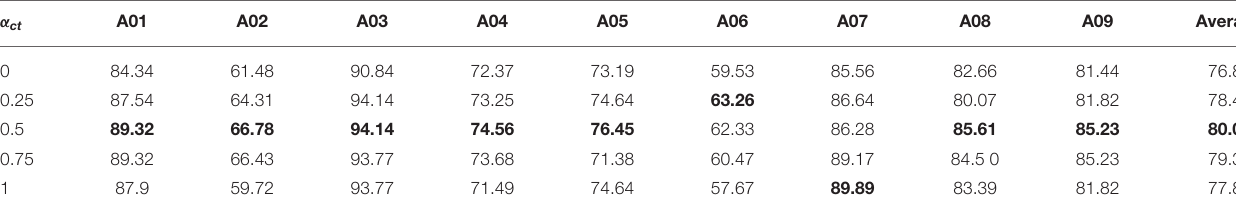
TABLE 7 | Classification accuracies (%) of models with different α ct values on the BCI competition IV-2a. α ct